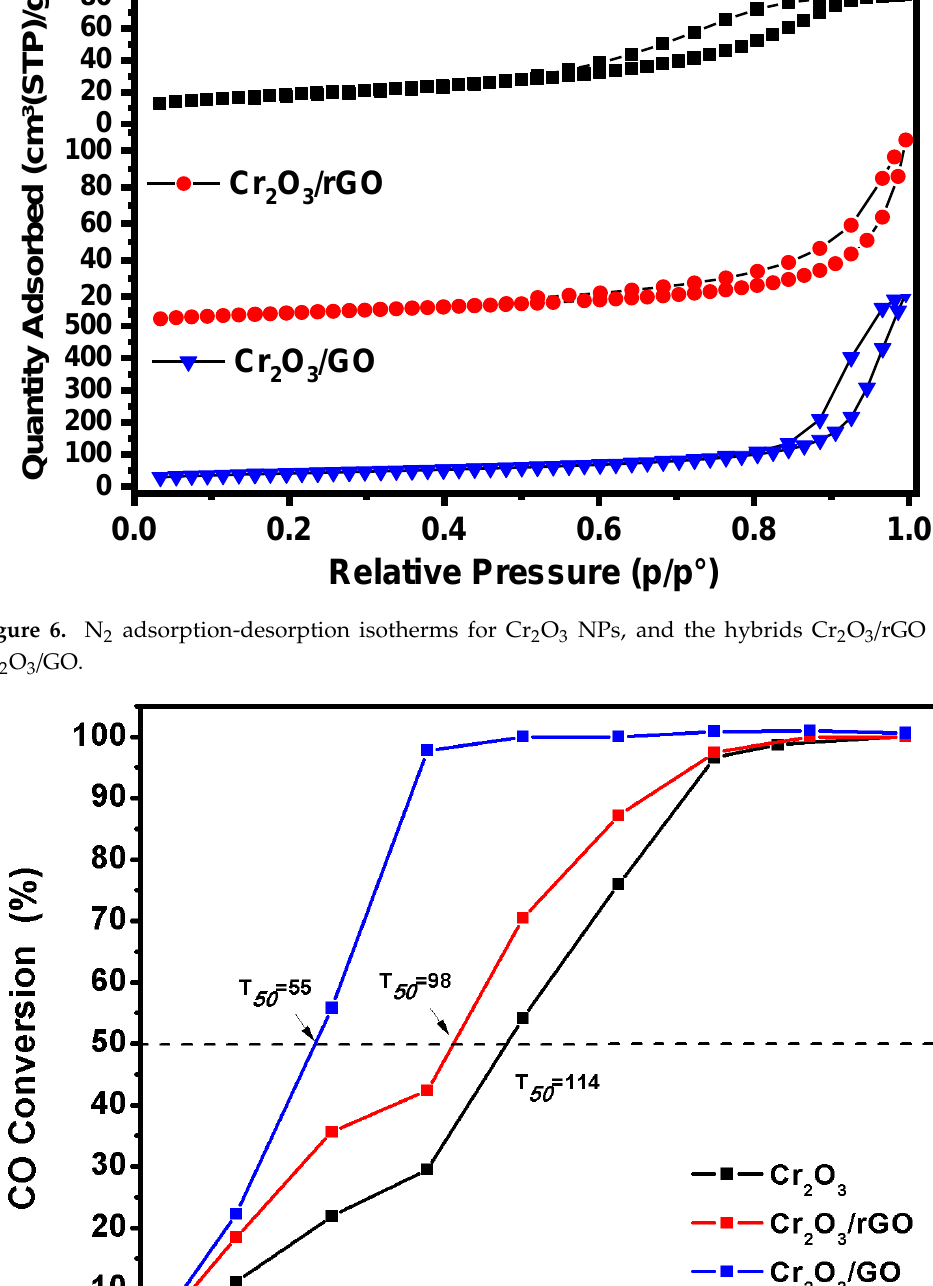
Figure 5. Deconvoluted XPS peaks of ( A ) Cr(2p) and ( B ) O(1s) for the crystalline Cr 2 O 3 ; ( C ) Cr(2p), ( E ) C(1s) and ( G ) O(1s) peaks for Cr 2 O 3 /GO; and ( D ) Cr(2p), ( F ) C(1s) and ( H ) O(1s) peaks for Cr 2 O 3 /rGO.